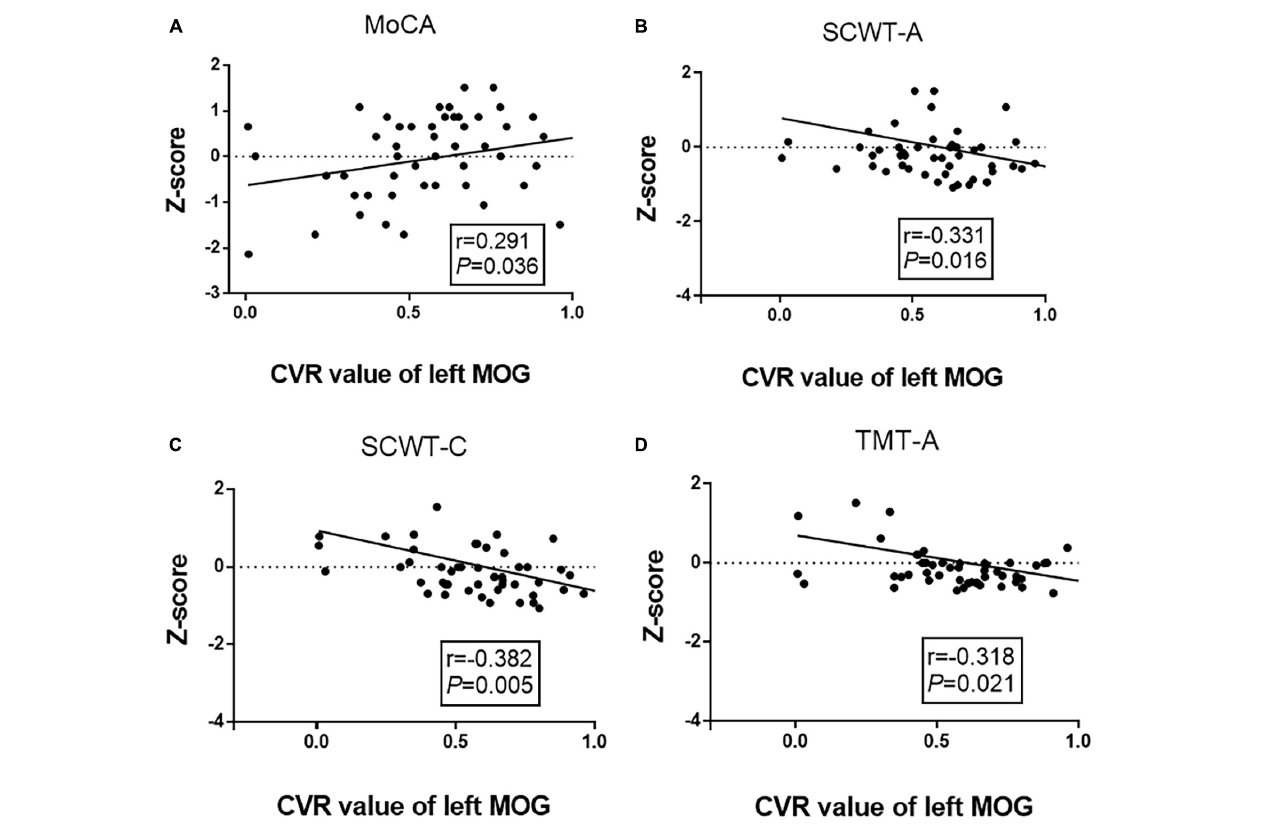
FIGURE 3 | Correlation analyses between cognitive function and CVR of the left MOG in the white matter hyperintensity (WMH)-III group. (A) The CVR of the left MOG was positively correlated with MoCA score ( r = 0.291, P = 0.036). (B) The CVR of the left MOG was negatively correlated with the time of SCWT-A ( r = –0.331, P = 0.016). (C) The CVR of the left MOG was negatively correlated with the time of SCWT-C ( r = –0.382, P = 0.005). (D) The CVR of the left MOG was negatively correlated with the time of TMT-A ( r = –0.318, P = 0.021). The scores were z-transformed scores of the relevant tests. CVR, cerebrovascular reactivity; MOG,